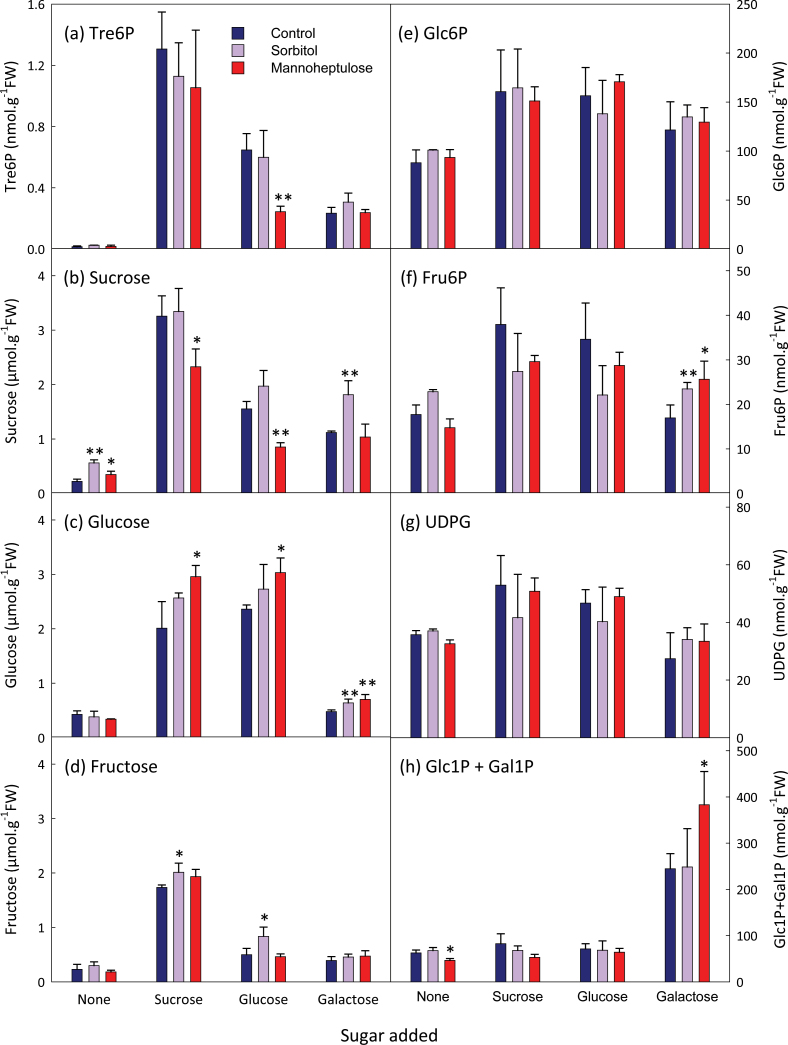
Effect of mannoheptulose on sucrose and hexose-induced increases in the Tre6P content of A. thaliana seedlings. After 7 d growth in 30ml of FN medium (15mM sucrose), seedlings were transferred to 15ml of sucrose-free medium on day 8 and again on day 9. The C-starved seedlings were incubated with 100mM mannoheptulose or 100mM sorbitol (osmotic control) for 1h before supplying sucrose (final concentration 7.5mM), glucose (15mM), or galactose (15mM). Metabolite values are mean±SD (n=2–4). Asterisks indicate significant differences (Student’s t-test) between the sorbitol- or mannoheptulose-treated seedlings and the respective controls: *P<0.05; **P<0.01. Glc1P, glucose 1-phosphate; Gal1P, galactose 1-phosphate.